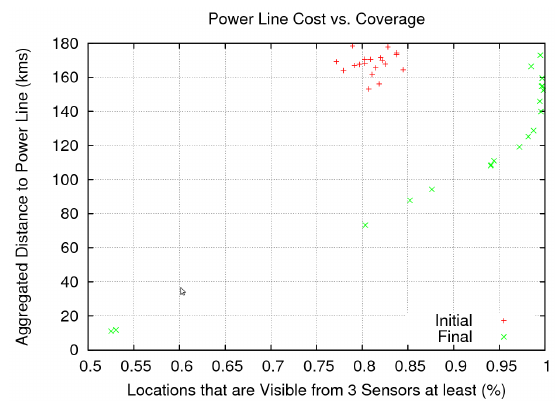
Figure 8. Aggregated distance to the power lines (cost) vs. coverage area with V ( x ) ≥ 3